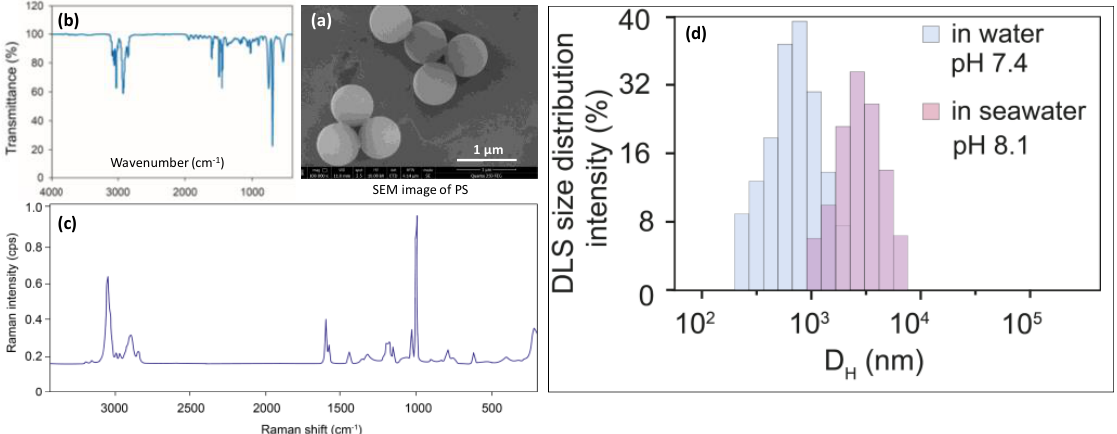
Figure 1. Characterization of PS particles used in this study. SEM image ( a ), infrared spectra ( b ), and Raman spectra ( c ), size distribution of the PS MPs measured by DLS ( d ). Aromatic C-H stretching vibration generated absorption peaks at the wave numbers of 3060 and 3026, and aromatic C=C stretching vibration generated three absorption peaks around the wave numbers of 1600, 1492, and 1452. The Raman spectrum of PS had a typical intense band at 1002 cm − 1 , which was linked to the breathing mode of the aromatic carbon ring.